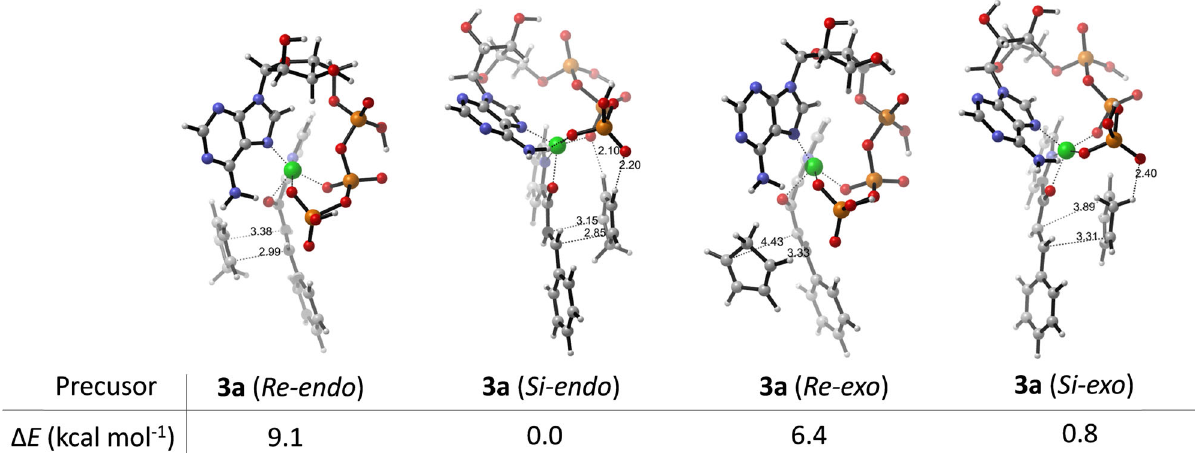
Supplementary Fig. 23. The precursors of the intermediates of 1a -Cu 2 + ⋅ ATP and 2 that yield the corresponding products 3a in different con fi gurations. The relative electronic energies ( Δ E) of the precursors are shown in the table.